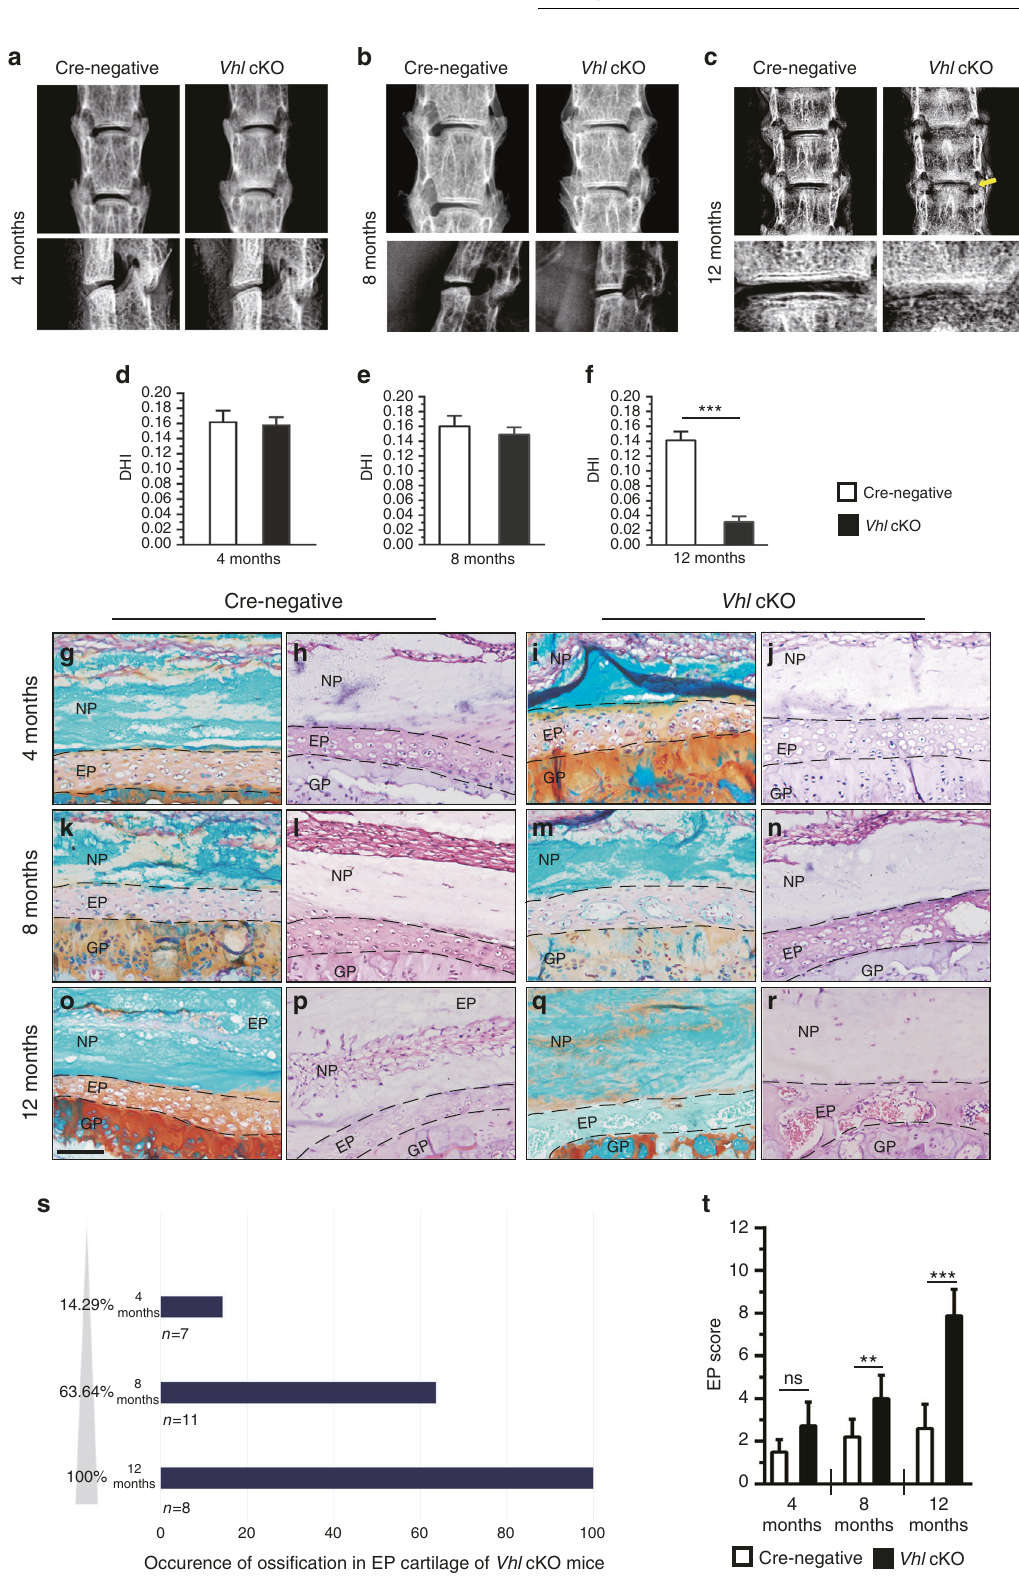
Fig. 3 Aberrant Hif1 α activation in IVD cells causes age-dependent degeneration. a – c Radiographic assessment of IVD phenotypes in Vhl cKO mice and control mice at 4, 8, and 12 months of age. The yellow arrow indicates the formation of osteophytes ( n = 7 – 8 per group). d – f Methods for measurement of the lengths between L4 and L5 (L4/L5) and for calculation of the disc height index (DHI). g – r Safranin-O/Fast green/H&E staining of lumbar IVDs at 4, 8, and 12 months ( n = 7 – 8). s Occurrence of ossi fi cation in EP cartilage of Vhl cKO mice. t Histological degenerative scores of EP cartilage in WT and Vhl cKO mice. Scale bar: 50 µm ( g – r ). Data are expressed as the percent expression relative to controls. Values represent the mean (symbols) ± SD (error bars). * P < 0.05; ** P < 0.01; *** P <